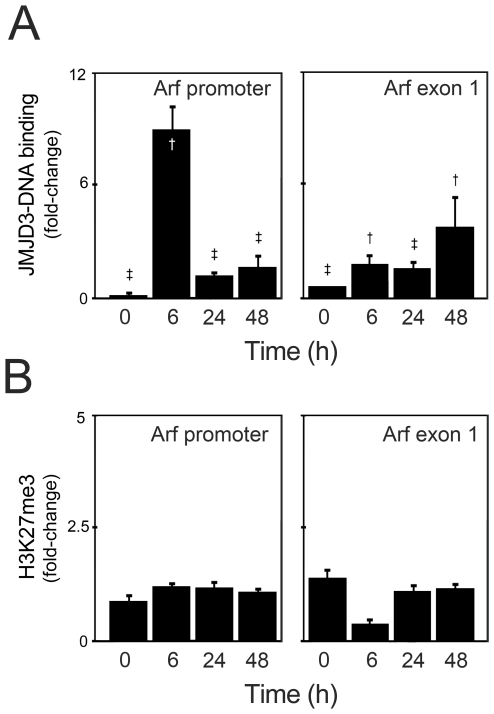
Enhanced recruitment of JMJD3 to the ARF locus during neural differentiation.Mouse NSCs were subjected to ChIP analysis at 0, 6, 24 and 48 h after differentiation, using antibodies and primer sets as described under “Material and Methods”. A, Presence of JMJD3 at both promoter and exon 1 regions of ARF locus in mouse NSCs under differentiation. Relative levels of JMJD3 immune complex were calculated by assigning the arbitrary value 1 to IgG levels. B, Absence of the histone mark H3K27me3 at promoter and exon 1 regions of ARF locus in mouse NSCs under differentiation. Hoxc8 was used as positive control. The results are expressed as mean ± SEM fold change of 6 independent experiments. *p<0.05, †p<0.01 and ‡p<0.001 from IgG controls.